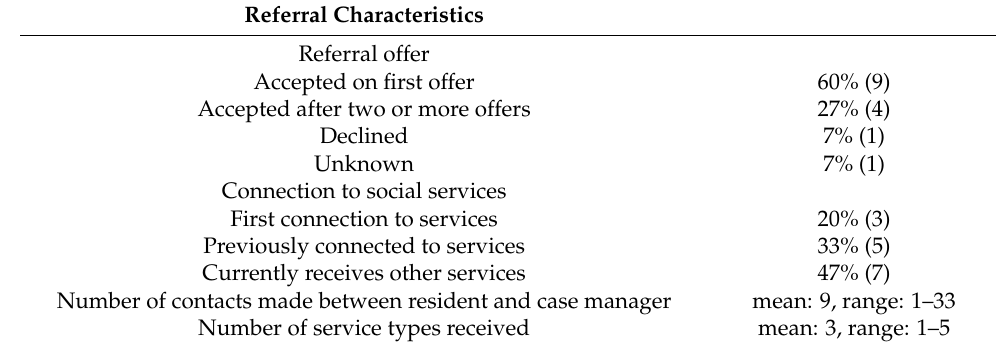
Table 2. Characteristics of